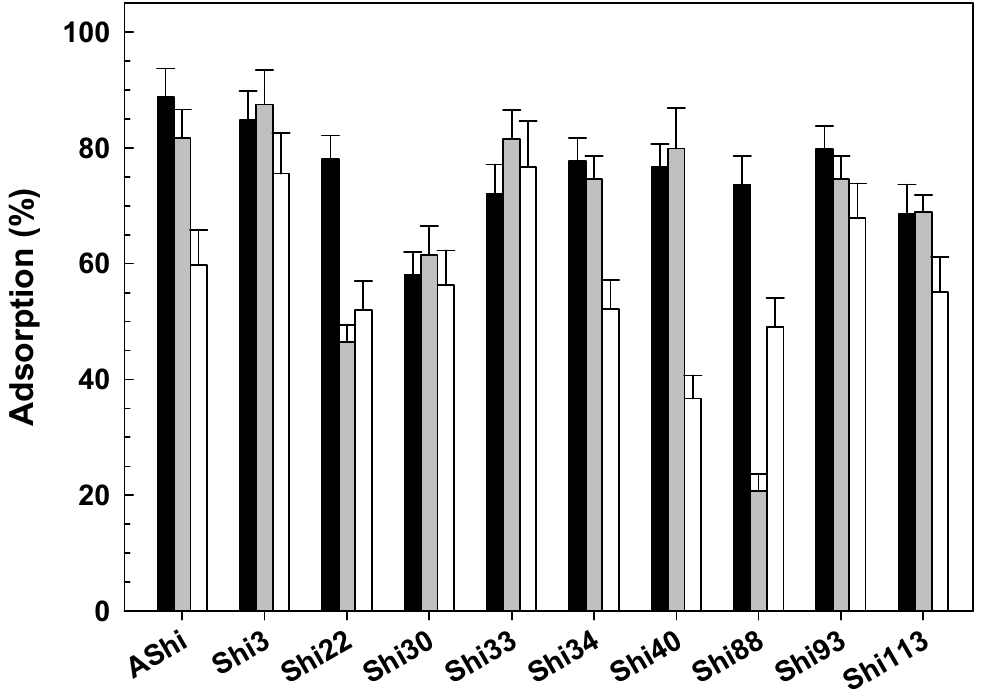
◦ Figure 4. Phage adsorption in TSB at 25 C and pH of 7.0 ( Figure 2. Phage adsorption in TSB at 4 °C (  ), 25 °C (  ; control), 37 °C (  ) and 50 °C (  ) on ; control), 4.0 ( Figure 2. Phage adsorption in TSB at 4 °C (  ), 25 °C (  ; control), 37 °C (  ) and 50 °C (  ) on ) and 10.0 ( Figure 2. Phage adsorption in TSB at 4 °C (  ), 25 °C (  ; control), 37 °C (  ) and 50 °C (  ) on ) on ATCC12022 viable cells. Values are the mean ± standard deviation (error bars) of three ATCC12022 viable cells. Values are the mean ± standard deviation (error bars) of three ATCC12022 viable cells. Values are the mean ± standard deviation (error bars) of three determina- Figure 4. Phage adsorption in TSB at 25 °C and pH of 7.0 (  ; control), 4.0 (  ) and 10.0 (  ) on determinations. determinations. tions. ATCC12022 viable cells. Values are the mean ± standard deviation (error bars) of three determina ‐ tions.